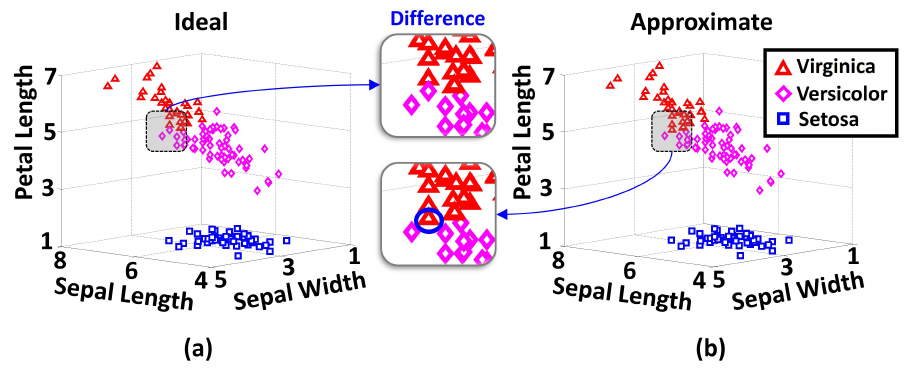
Figure 11. Final clustering results comparison: ( a ) ideal K-means clustering result; ( b ) approximate K-means clustering result. The single error occurs at the boundary of the two